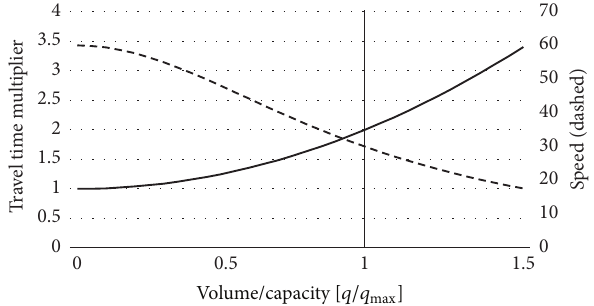
Figure 1: Travel time multiplier and speed in the BPR function.